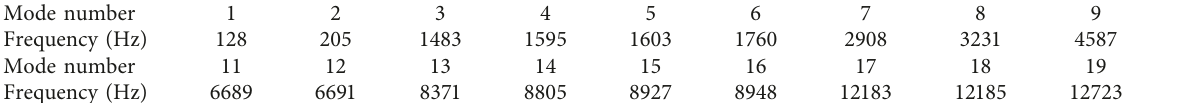
Table 4: Natural frequencies of the system for the first 20 orders.